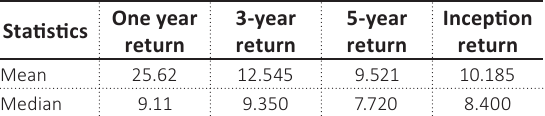
Table 1. Classification of mutual funds based